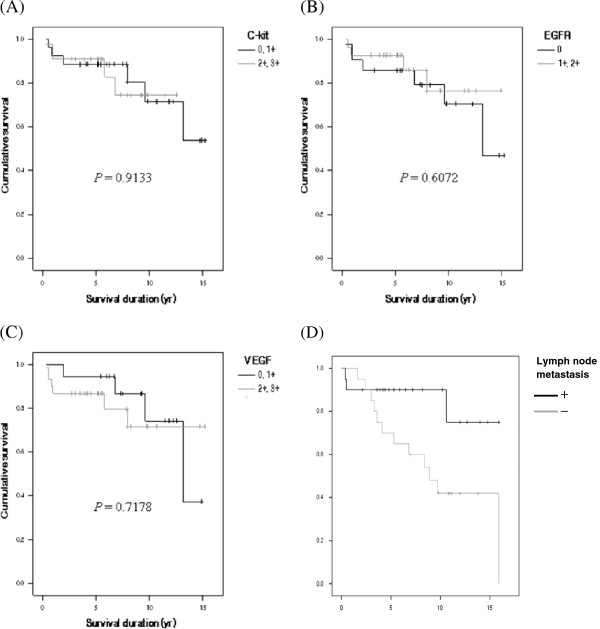
Overall survival curves of the patients according to (A) c-kit, (B) epidermal growth factor receptor (EGFR), (C) vascular endothelial growth factor (VEGF) expression, and (D) lymph node metastasis. Survival curves were calculated using the Kaplan-Meier method and analyzed by the log-rank test.